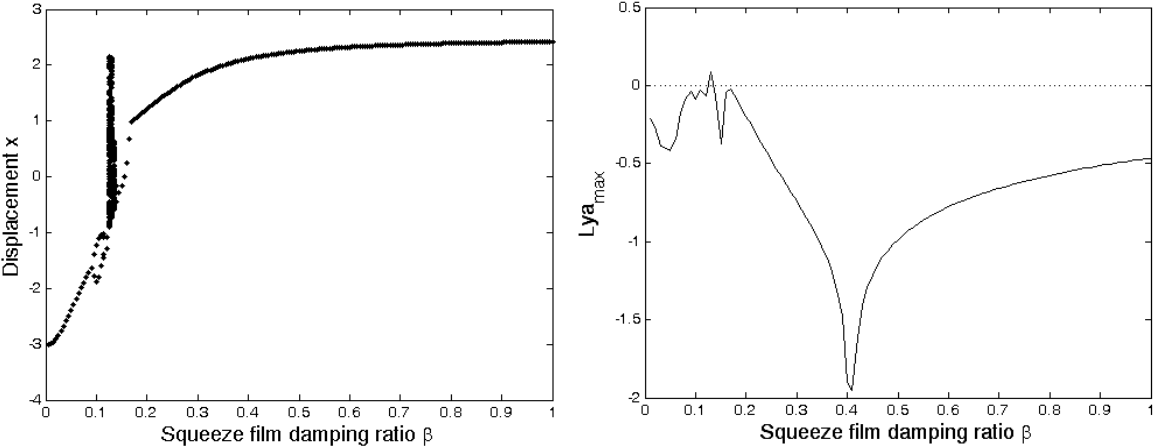
Fig. 8. Bifurcation diagram and largest Laypunov exponent map of β for the coupling nonlinear dynamic system with V dc = 0 and V ac = 40 V.